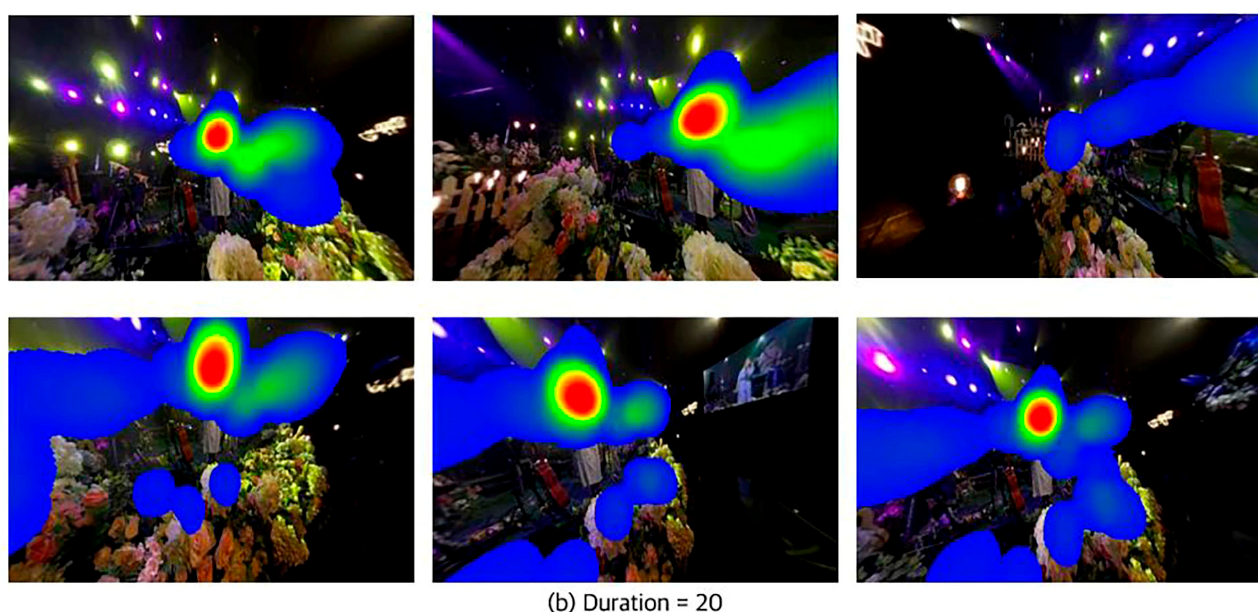
Figure 13. Heatmap comparison based on duration value.